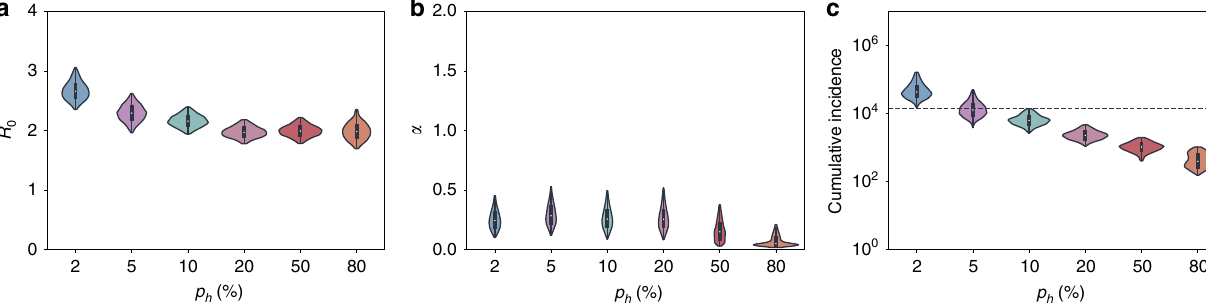
Fig. 5 Estimated epidemiological parameters and cumulative incidence across different levels of transmission heterogeneity. The parameter p h gives the fraction of infected individuals that are responsible for 80% of secondary infections. Higher p h values correspond to less transmission heterogeneity. a Estimated R 0 in Israel prior to March 19, 2020. b Estimated factor by which R 0 in Israel changed after March 19. c Estimated cumulative number of infected individuals in Israel on the date of the last sampled sequence (April 22, 2020). Horizontal dotted line at N = 13,942 shows the cumulative number of reported cases on April 22, 2020, as given by the ECDC (https://opendata.ecdc.europa.eu/covid19/casedistribution/csv). In a – c , only values that fall within the 95% highest posterior density intervals from the main MCMC chain are shown (total of 4751 data points). Violin plots show the kernel density estimation of the underlying distribution. The median value is denoted by a white dot and the black bar in the center of the violin de fi nes the interquartile range. The black line stretched from the bar extends to the range of data that are not more than 1.5 times the interqaurtile range above the upper or below the lower quartile. Density is only plotted over the range of observed values. Results shown assume a time-varying migration rate estimated from a global maximum-likelihood phylogeny. Source data are provided as a Source Data fi